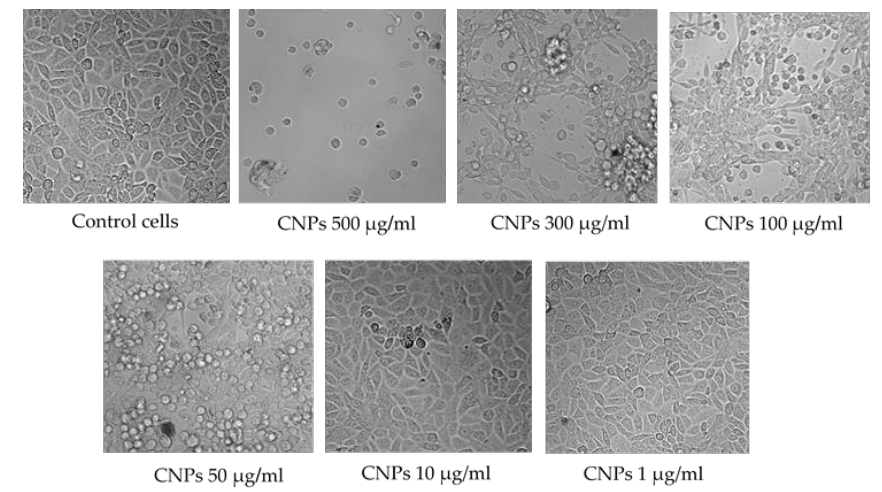
Figure 9. MTT assay with MAL-CNPs on treated cells.